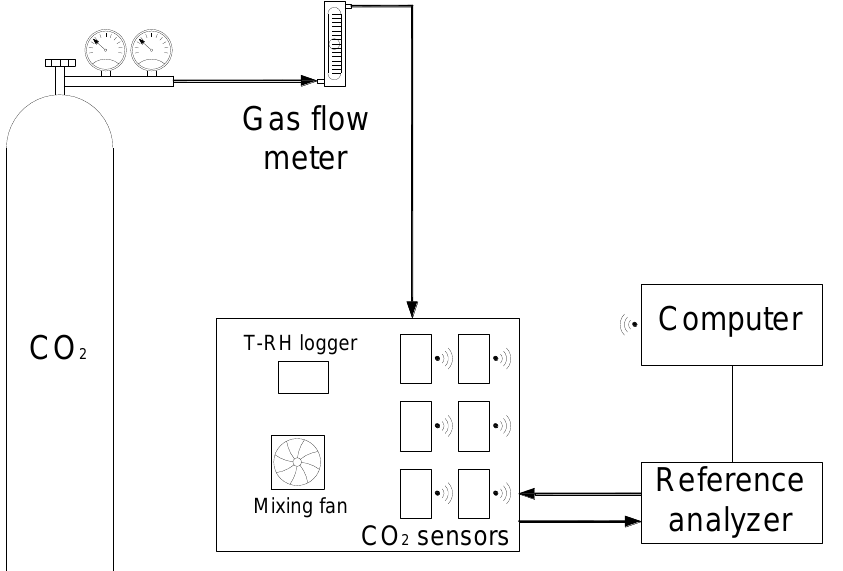
Figure 7. Experimental setup including closed chamber, gas source and reference